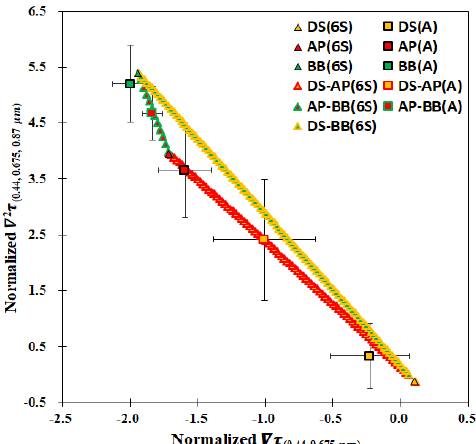
Figure 7. The second–order derivative (normalized ∇ 2 τ ) versus first–order derivative (normalized ∇ τ ) of dual–component mixtures (DS–BB, DS–AP and AP–BB, denoted as “6S”) simulated with 0.01 step from 0.00 to 1.00 in mixing weights of volume density from the 6S model. The measurements of AERONET sites (denoted as “A”) are collocated together with the mean value and standard deviation of spectral derivatives for DS, AP, BB, DS–AP, DS–BB and AP–BB aerosols.